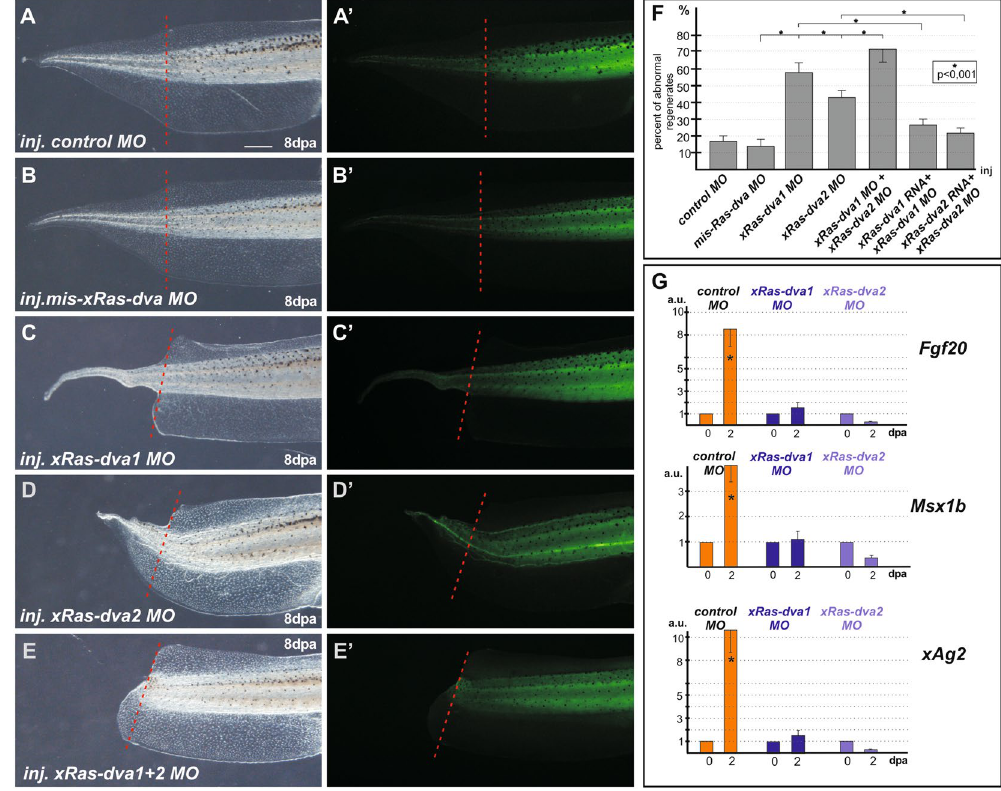
Figure 5. Down-regulation of xRas-dva1 and xRas-dva2 genes functioning results in abnormal regeneration of tadpole’s tails. ( A – E ) The transmitted light and fluorescent images of regenerated tails of 8 dpa tadpoles injected by solution of control MO ( A ), mismatched mis-xRas-dva MO ( B ), xRas-dva1 MO ( C ), xRas-dva2 MO ( D ) or xRas-dva1 MO + xRas-dva2 MO ( E ) mixed with fluorescent tracer FLD. The red dashed line indicates the amputation level. Scale bar 0,5 mm. ( F ) Quantification of abnormal regenerates percentage of tadpoles, injected by different MO solutions or by the “rescue” mixtures of xRas-dva1 MO + xRas-dva1 RNA , xRas-dva2 MO + xRas-dva2 RNA . Error bars indicate SD. Statistical significance was determined with paired sample t-test, the results are statistically significant, p < 0,001 (asterisk). ( G ) qRT-PCR analysis of expression levels changes of regeneration markers Fgf20, Msx1b and also Xenopus Ag1 homolog, xAg2 , during the regeneration process (at 0 and 2 dpa) in amputated tails of tadpoles injected by control , xRas-dva1 or xRas-dva2 MO solution. The value of normalized PCR signal in the 0 dpa sample, harvested immediately after amputation, was taken as an arbitrary unit (a.u.) in each series. Data are represented as mean ± SD, t-test, p < 0,05